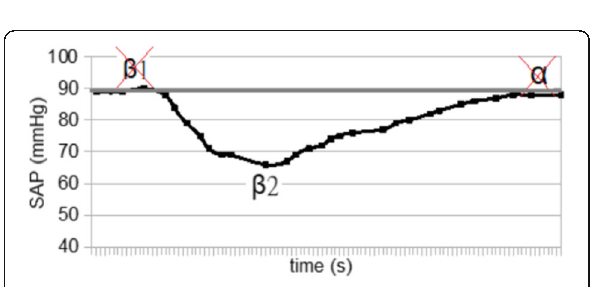
Fig. 3 (abstract A16). Interaction etilefrine-urapidil